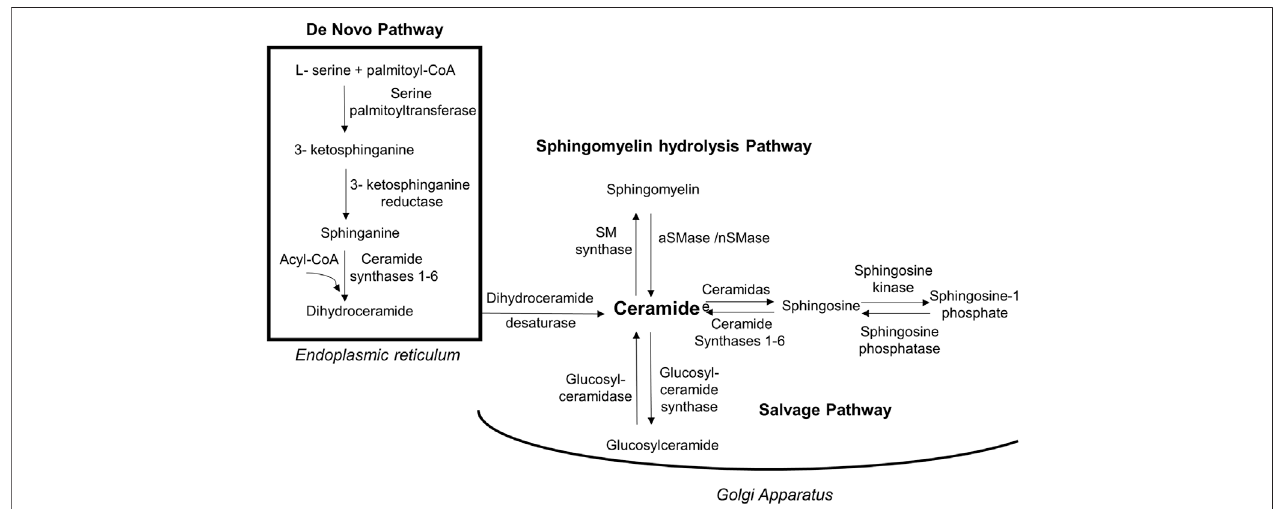
FIGURE 2 | Biosynthesis routes of ceramides. Ceramides are synthesized via 3 pathways. Firstly, de novo synthesis of ceramides starts in endoplasmic reticulum by coupling amino acid serine to palmityl-CoA using palmitoyltransferase in a multi-step process and yielding dihydroceramide that will be activated into ceramide by dihydroceramide desaturase. Secondly, in Golgi apparatus ceramides can be generated by sphingomyelin hydrolysis via acidic/neutral sphingomyelinase. The third biosynthesis method is through salvage pathway in which glucosylceramide is converted into ceramides via glucosylceramidase. Moreover, ceramides can be metabolized into less toxic sphingosine that get phosphorylated to sphingosine-1phosphate via sphingosine kinase. [aSMase, acid sphingomyelinase; nSMase, neutral sphingomyelinase; SM, sphingomyelin].